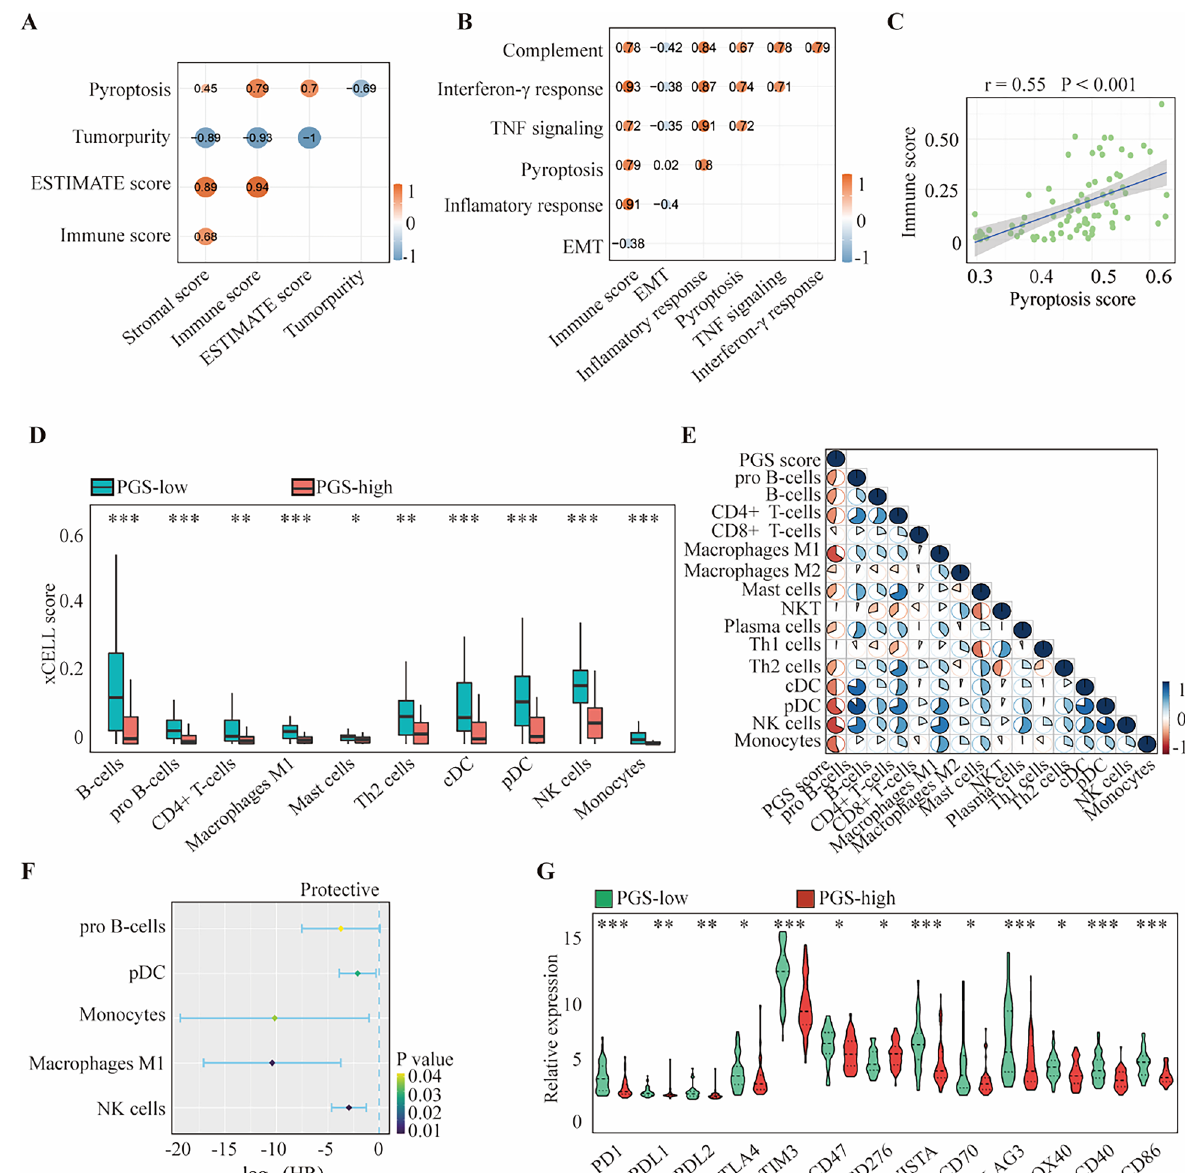
Figure 5. The interrelationship between the PGS and immune cells infiltration. ( A ) Spearman association analysis between immune cells, stromal cell infiltration and pyroptosis. ( B ) The interrelationship between cancer hallmarks and pyroptosis. ( C ) The interrelationship between immune score and pyroptosis score. ( D ) The infiltration level of 10 immune cells in PGS-low and -high groups. ( E ) The association between the PGS score and various immune cells. ( F ) Multivariate Cox regression analysis to identify various prognostic immune cell types in the forest plot of the HR values. ( G ) The expression pattern of immune checkpoint-related and immune active genes in the PGS-low and -high groups. Statistical analysis: * p < 0.05, ** p < 0.01, *** p < 0.001. This figure was created using R software version 4.0.3 (https:// www.r- proje ct.